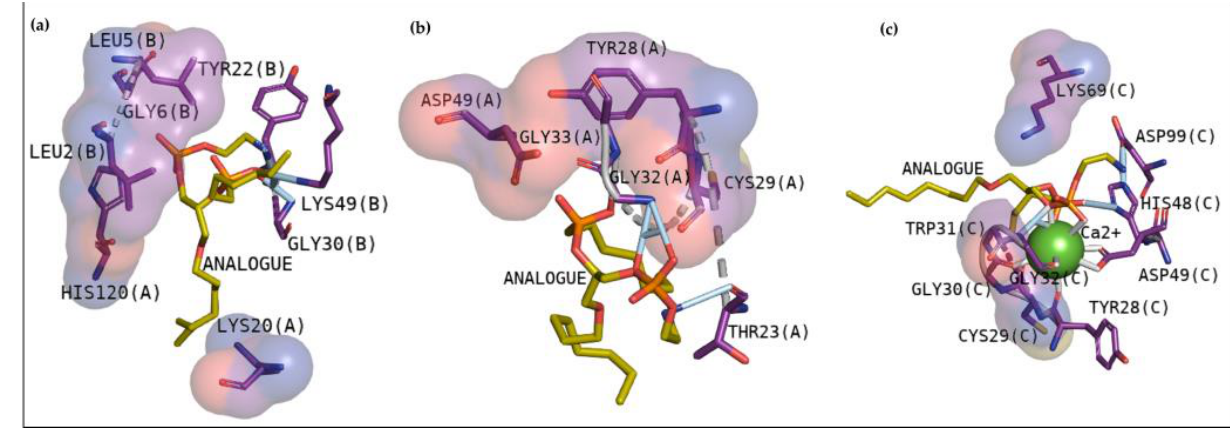
Figure 3. Interactions between BthTX-I ( a ), BthTX-II ( b ) and CdtsPLA2 ( c ) with a phosphonate transition-state analogue.